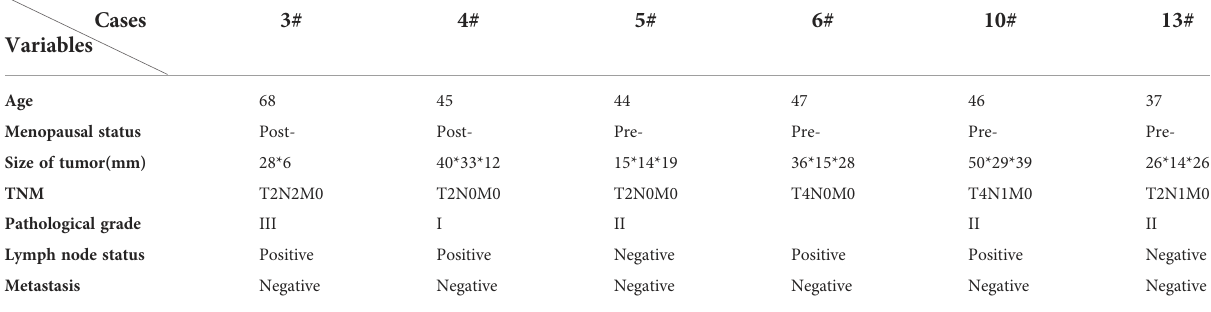
TABLE 3 Clinicopathological status in 6 cases of patients with breast cancer.